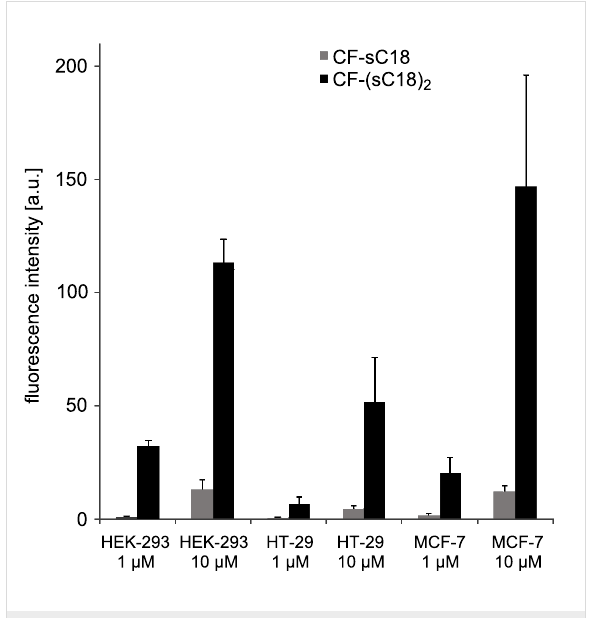
Figure 1: Flow cytometric uptake studies of carboxyfluorescein- labeled (sC18) 2 in HEK-293 (human embryonic kidney) cells, HT-29 cells (human colon adenocarcinoma) and MCF-7 cells (human breast adenocarcinoma) with sC18 as reference after 1 h incubation. Experi- ments were conducted in duplicate with n = 2. Error bars represent the standard